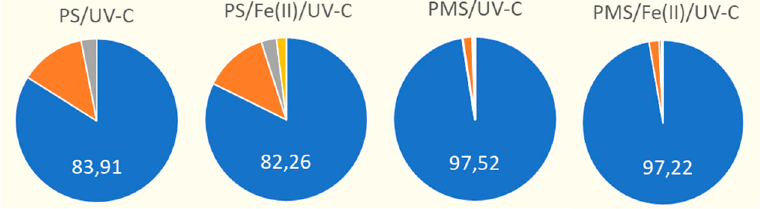
▪ Oxidant ▪ Iron (II) ▪ Energy UV-C ▪ Energy Figure 4 . Cost breakdown for different SR-AOPs.